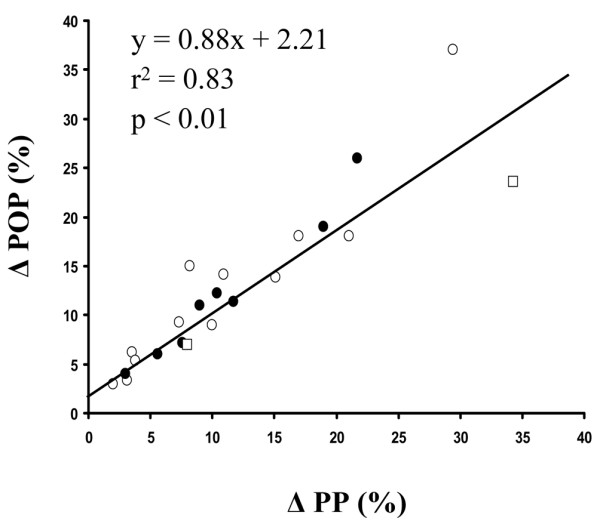
Relationship between ΔPOP and ΔPP. Empty circles indicate patients receiving vasopressor support, and empty squares indicate patients with severe hypotension. ΔPOP, respiratory variations in POP waveform amplitude; ΔPP, respiratory variations in systemic pulse pressure.